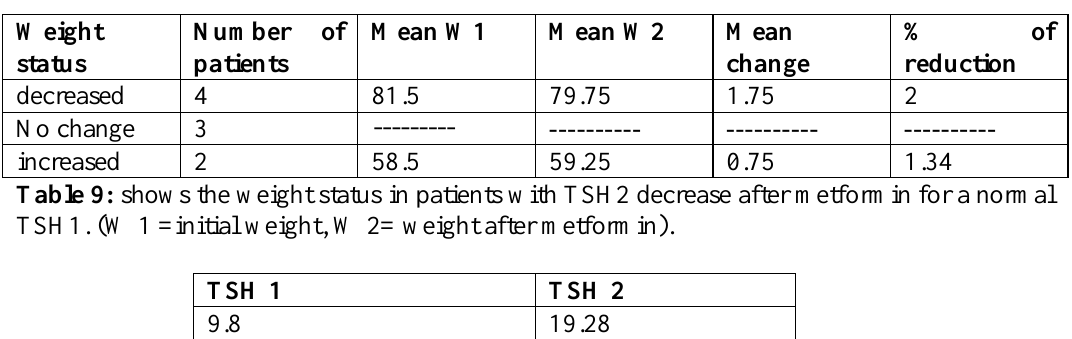
Table 8: shows the weight status in 40 patients with high initial TSH who their TSH level decreased after metformin. (W 1 =initial weight, W 2= weight after metformin).